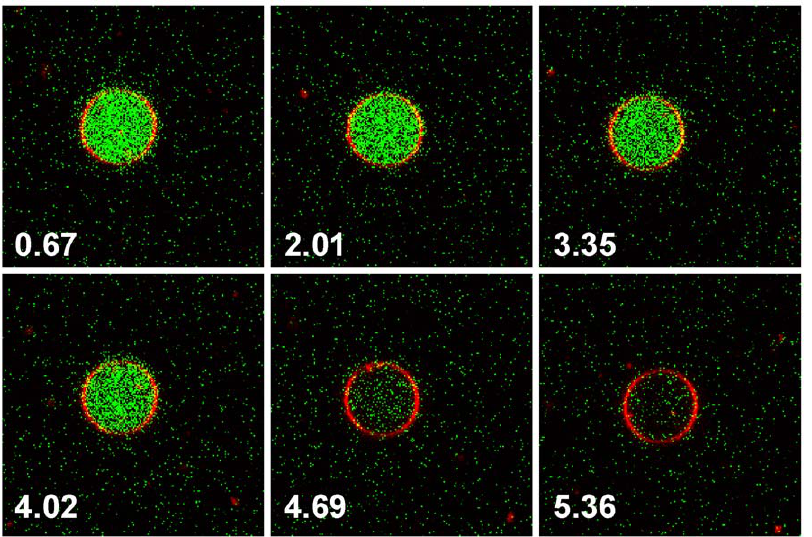
Figure 2. Confocal microscopy images of POPG GUVs filled with the dye HPTS (green). The quencher DPX was present on the outside of the vesicles. The GUV membrane was stained with DOPE-Rhodamine (red). The consecutive images (time stamp in seconds) show the kinetics of dye efflux from a single GUV. These data are also presented as a movie (see Movie S1).